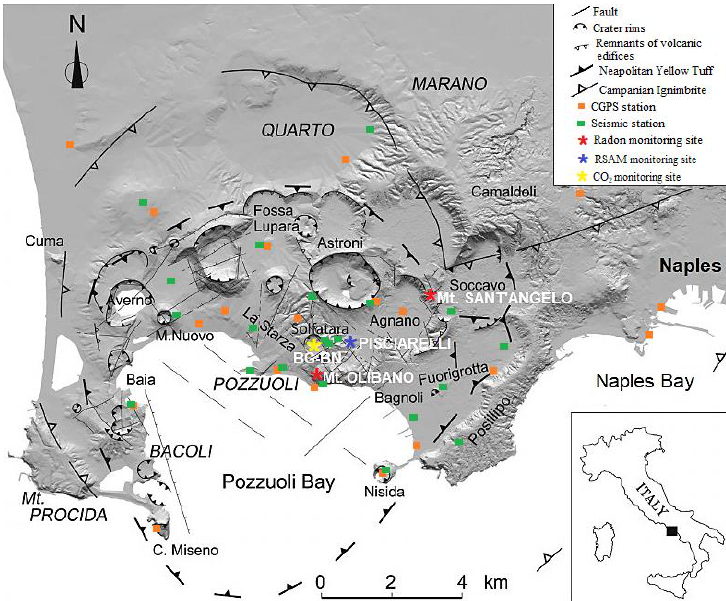
Figure 1. Map of the Campi Flegrei caldera (Naples, Italy) from [1,18]. The map shows the structural setting of the caldera characterized by tectonics and volcano-tectonic activity. The two radon monitoring sites of Monte Olibano and Monte Sant’Angelo, and the other monitoring sites of geochemical and geophysical parameters are reported.